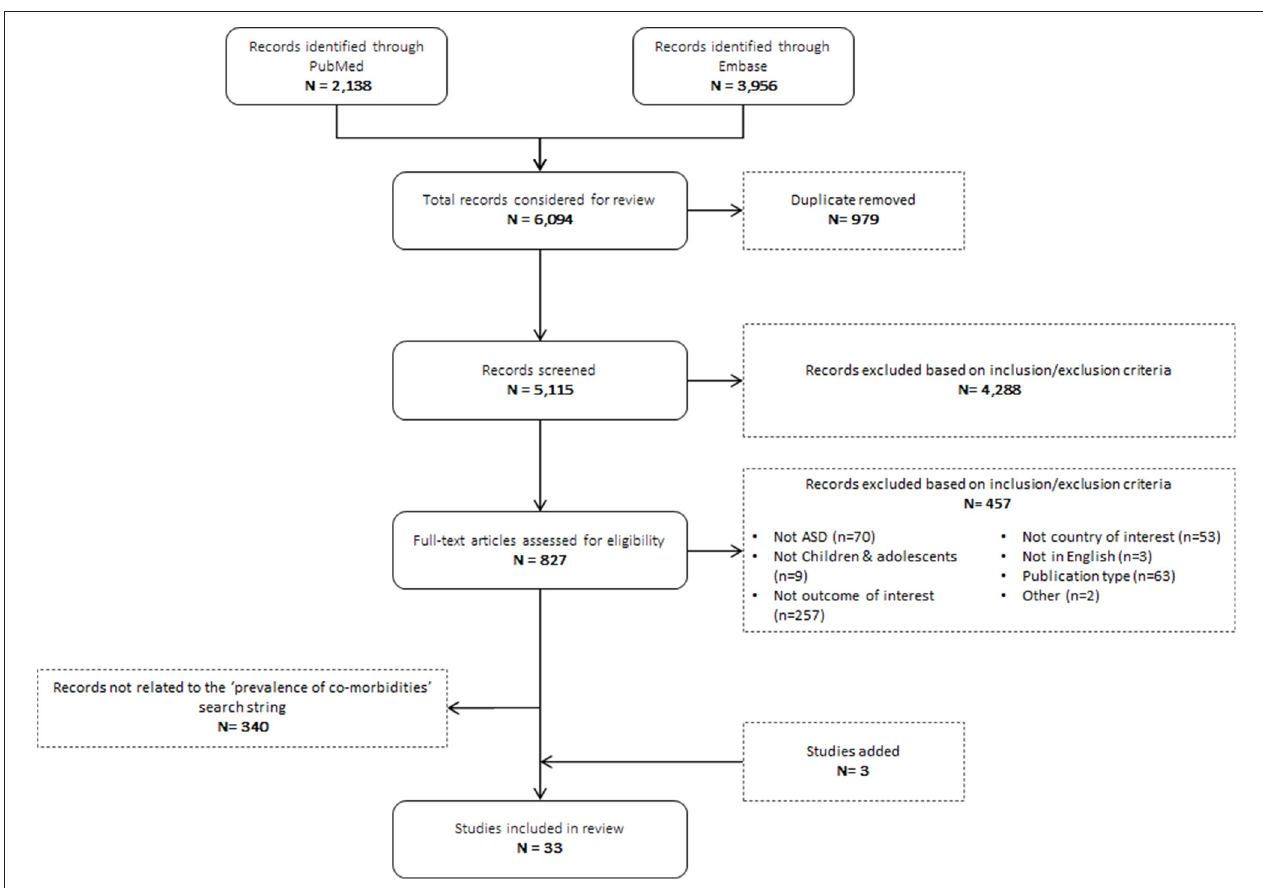
FIGURE 2 | PRISMA diagram prevalence of co-morbidities in ASD.